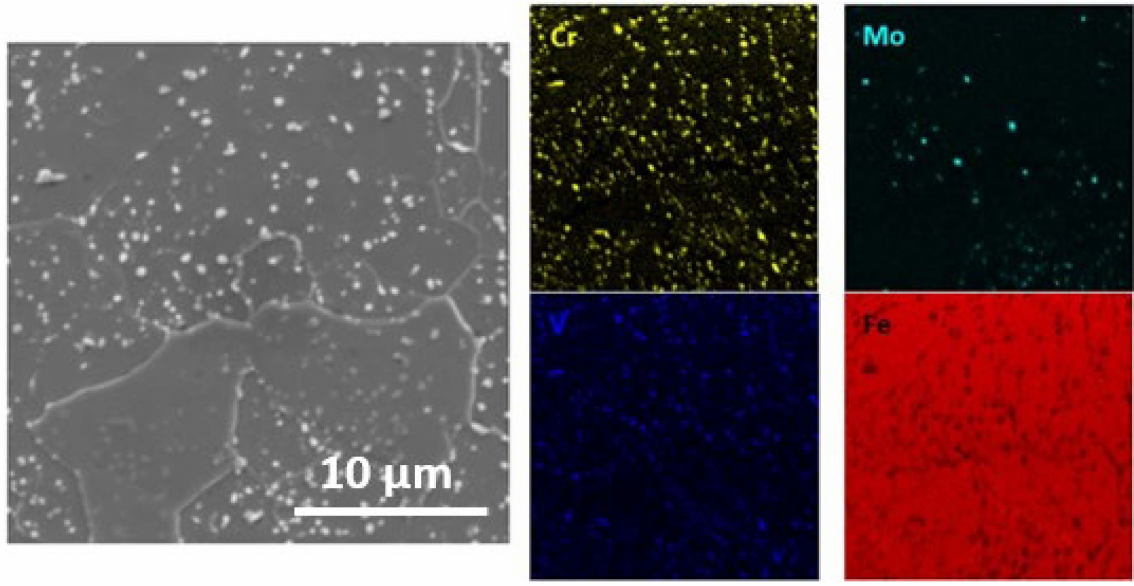
Figure 5. Qualitative EDS of X37CrMoV5-1 in the as-delivered